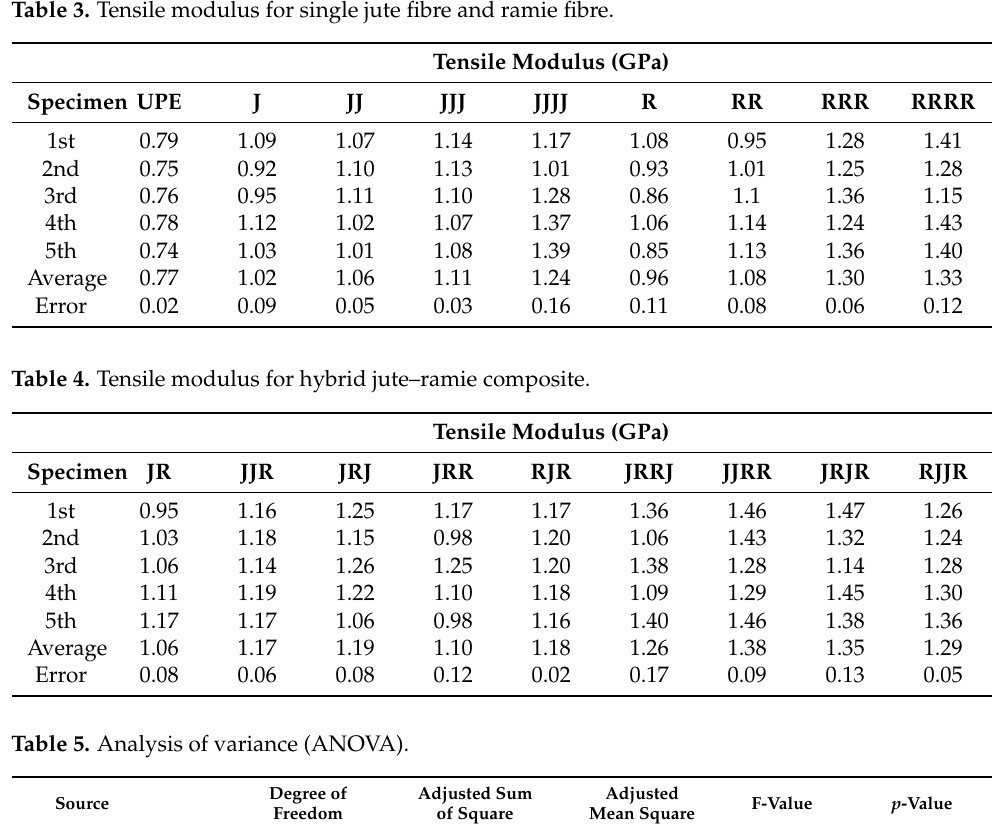
Table 3. Tensile modulus for single jute fibre and ramie fibre.